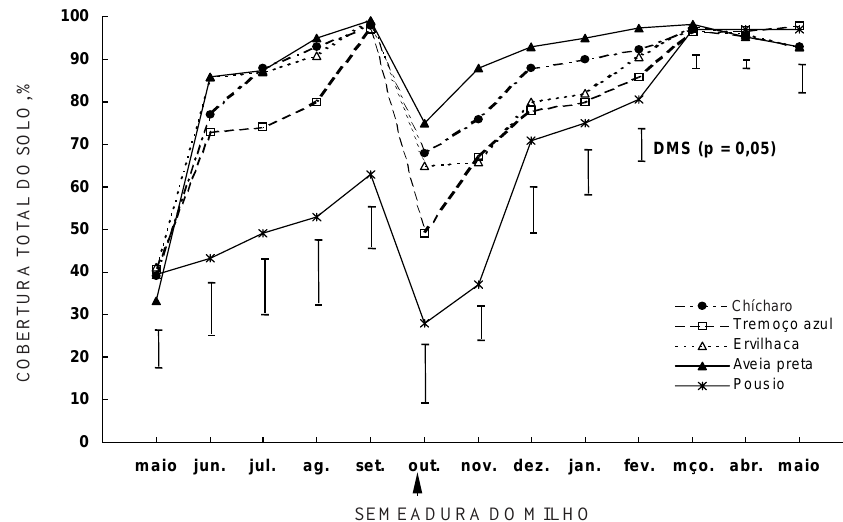
102030405060708090100 0 maio jun. jul. Figura 4. Variação temporal da cobertura total do solo por plantas de inverno, pousio invernal e cultura do milho. Diferença mínima significativa (DMS) pelo teste t (p = 0,05).